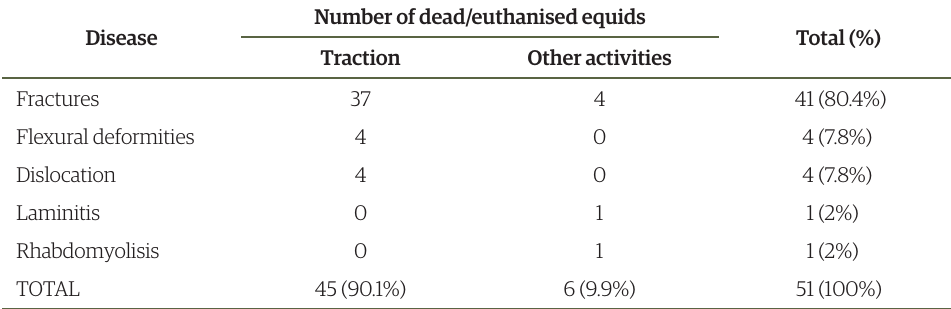
table 2. Total number and percentage of deaths/euthanasia per orthopedic disease in 51 equids attended at the Large Animal Veterinary Teaching Hospital of Universidade de Brasília, from March 2016 to February